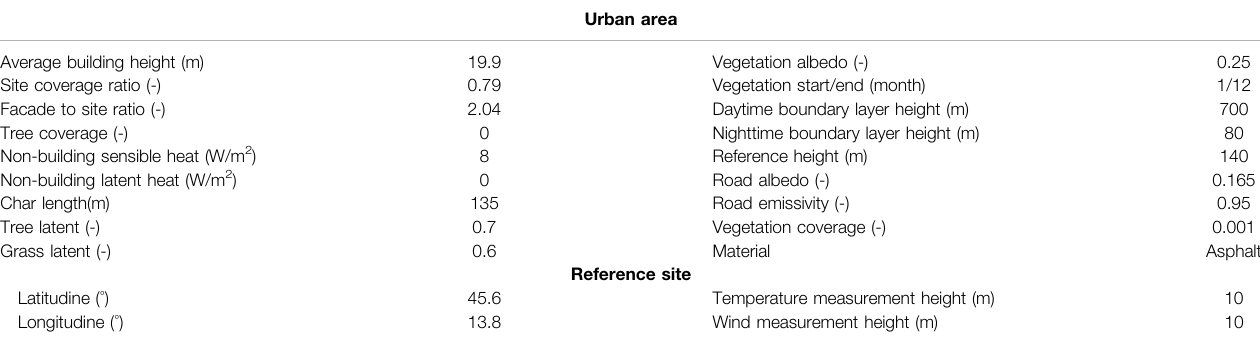
TABLE 3 | Main parameters of the UWG model.